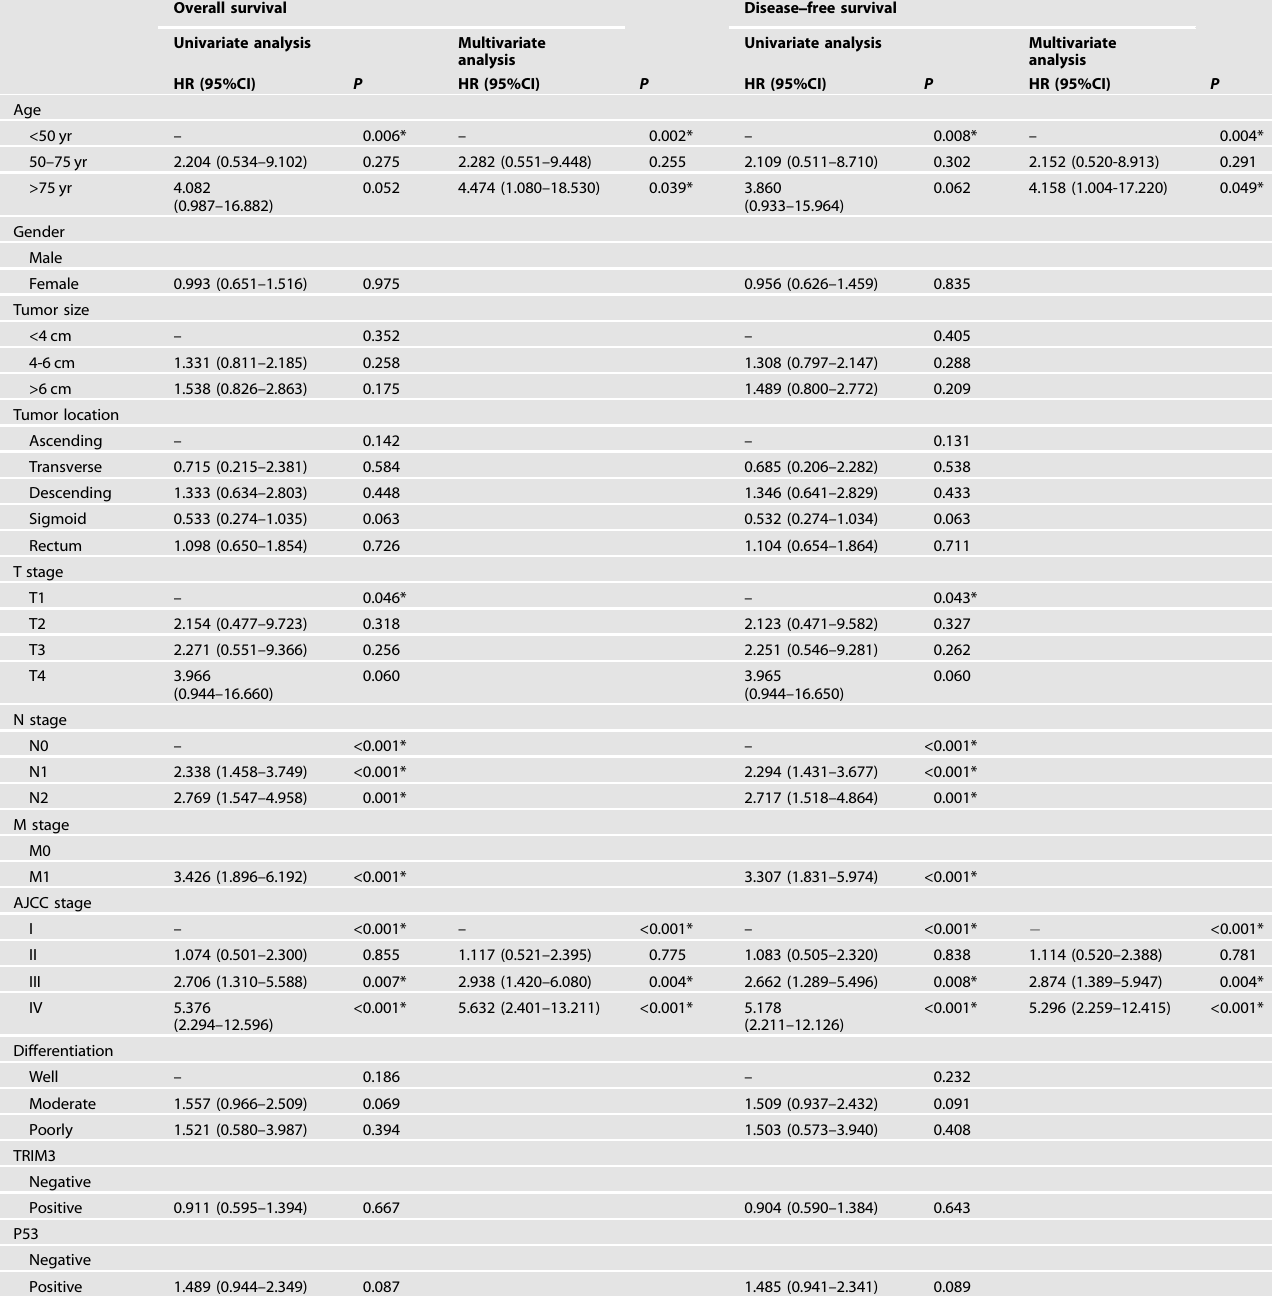
Table 3. Univariate and multivariate analysis of overall survival and disease ‒ free survival after surgery ( N = 348). Overall